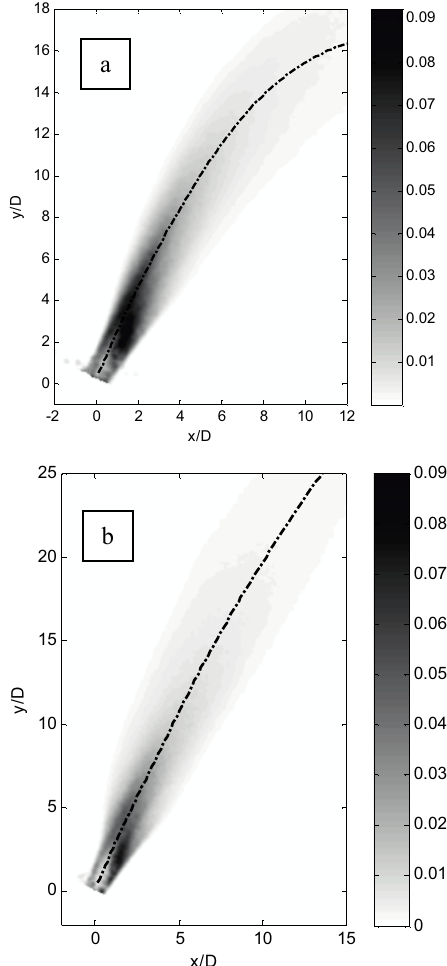
Figure 5. Map of the non-dimensional Turbulent 2 in the near-field of an INBJ Kinetic Energy TKE/U max with Re = 1000, θ = 65°, Fr = 8 (a) and 15 (b); the dash- dotted line is the jet axis. The values in the lower region tend to be higher than the ones in the upper region, until around s/D = 6, where the upper region curve collapses into the lower region one. These higher values in the lower region are due to the local unstable stratification, with more intense velocity fluctuations due to the different directions of local momentum and buoyancy. The simple jet values tend to initially stay between the upper region and the lower region values, but showing a smoother trend, with a less pronounced peak, to then collapse, after around 10 diameters from the origin, to the INBJ